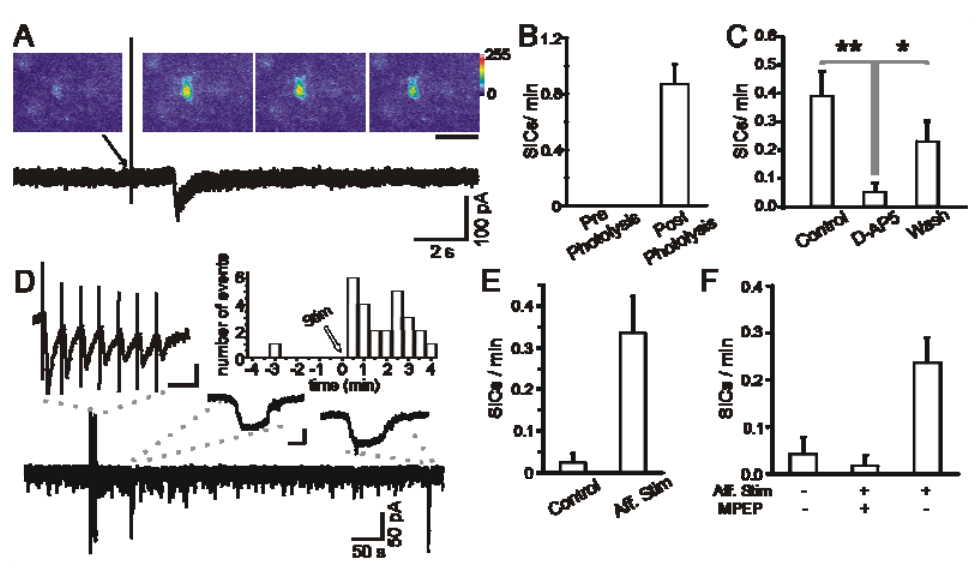
FIGURE 3 . Ca 2+ -dependent glutamate release from astrocytes generates SICs in medium spiny neurons. (A–C) Selective photolysis of astrocytic caged Ca 2+ results in the detection of SICs in nearby nucleus accumbens neurons. (D–F) Glutamatergic afferent stimulation activates astrocytic Ca 2+ (see Fig. 2), activates Ca 2+ -dependent gliotransmission, and thus increases the frequency of SICs recorded in medium spiny neurons. Activation of